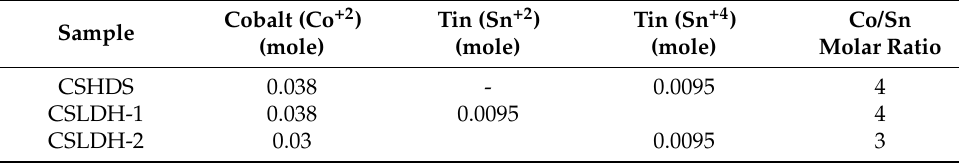
Table 1. Different percentages and ratios of both cobalt and